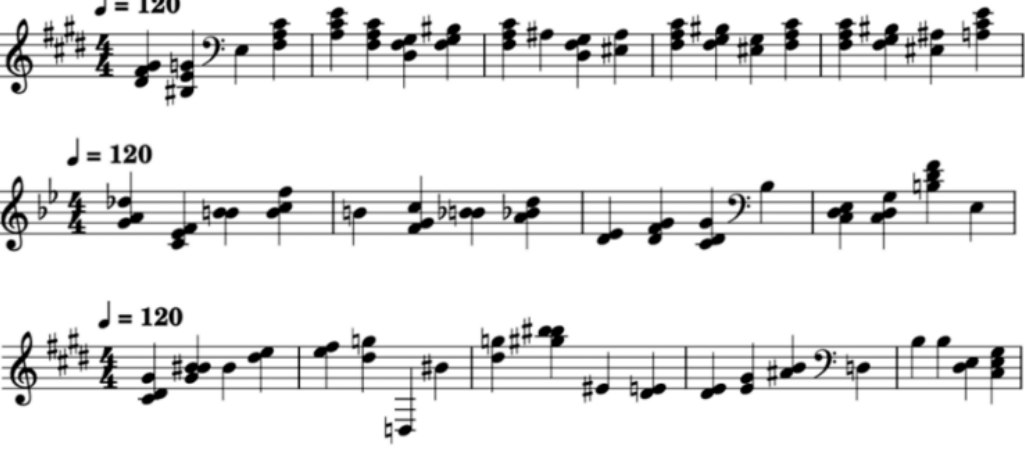
Table 3. The form for music